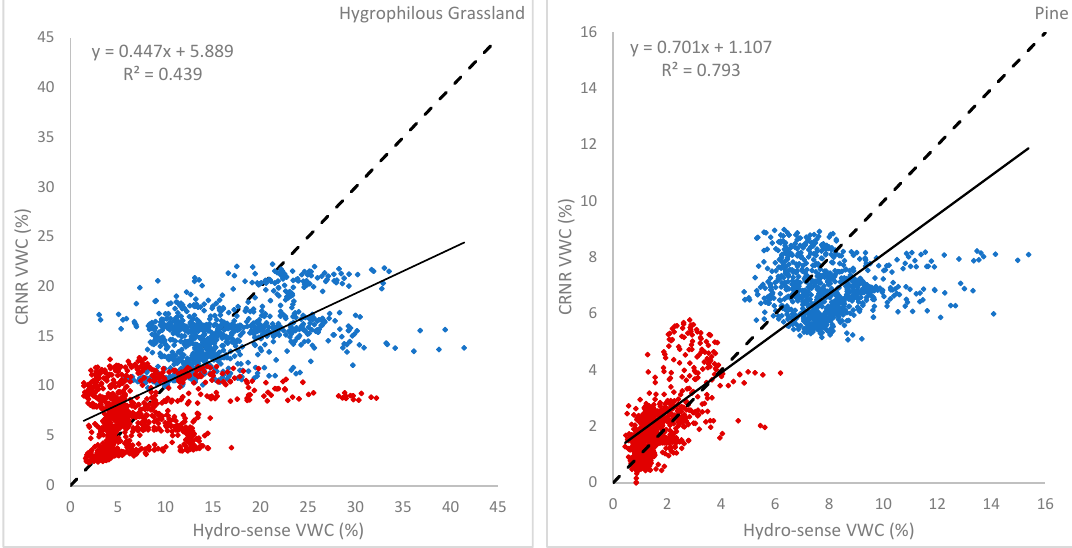
Figure 11. Scatterplot of hydro-sense ( x -axis) and CRNR ( y -axis).